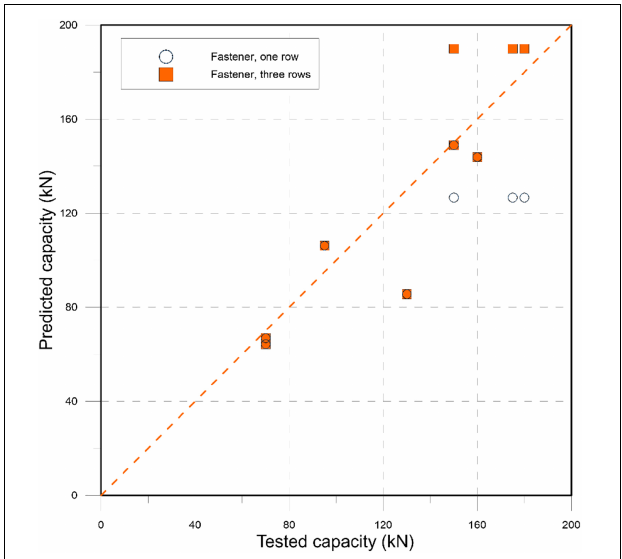
FIGURE 7 | Predicted capacity vs. tested capacity for the “fastener” model accounting for different numbers of engaged